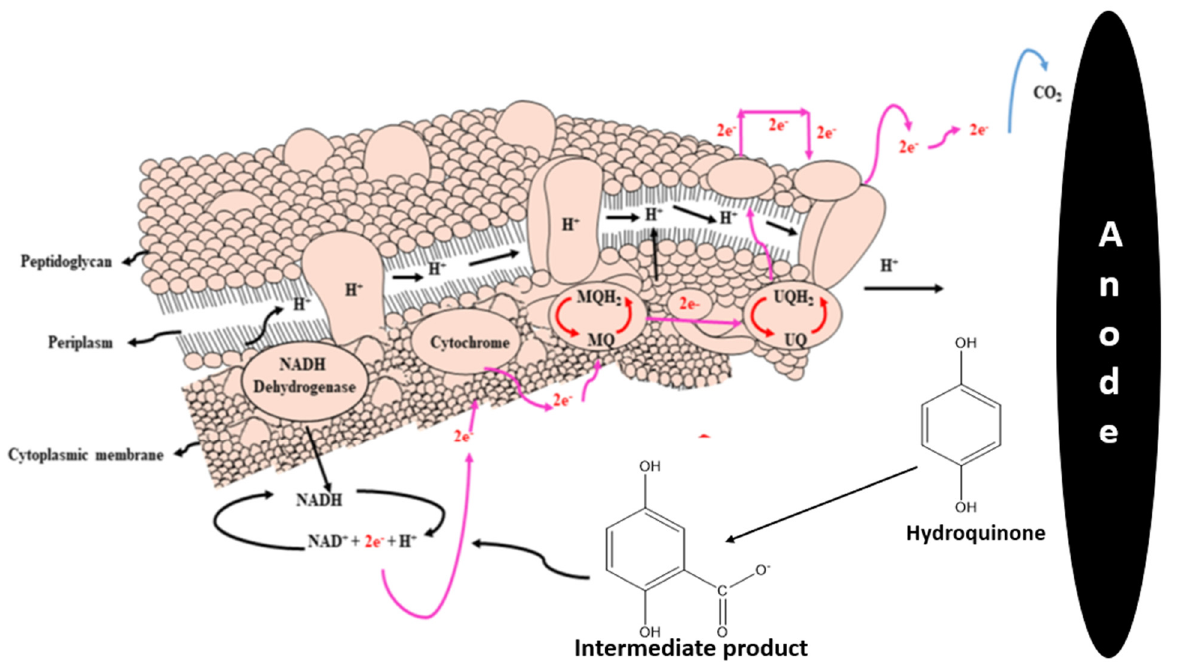
Figure 5. Microbial degradation of hydroquinone in a single-chamber MFC (Idea and figure modified according to the present study from reference [43] with Elsevier permission).